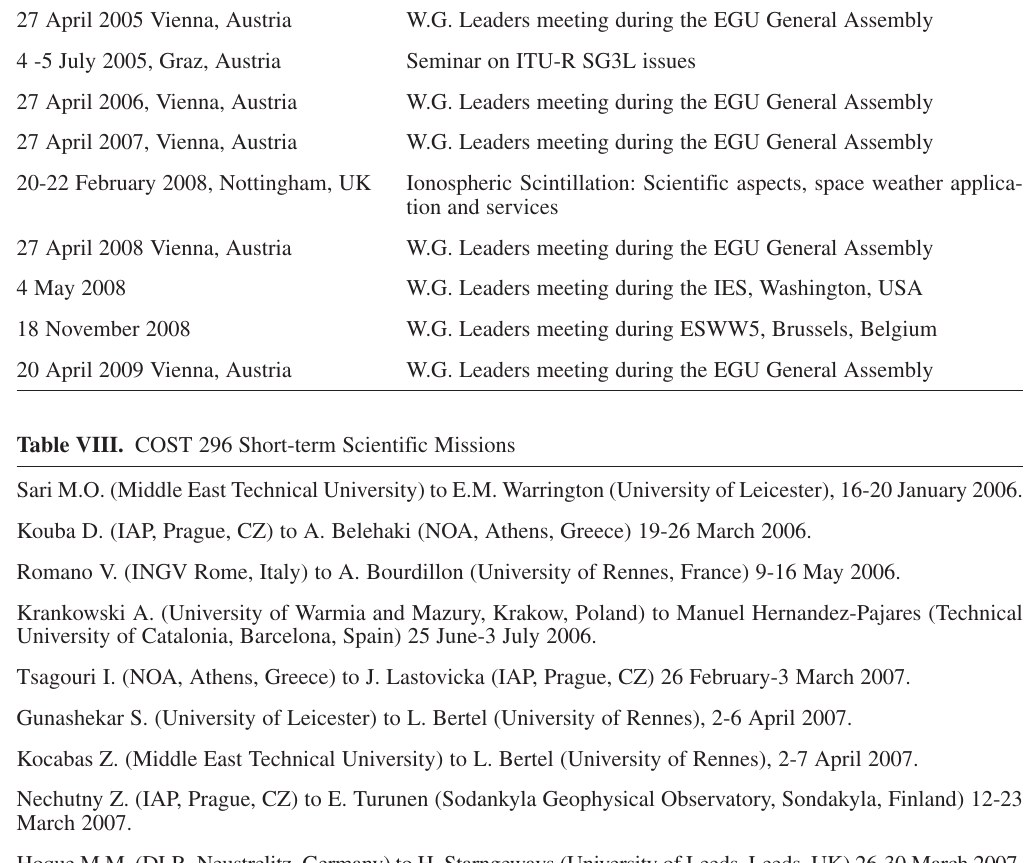
Table VII. COST 296 Meetings of the Working